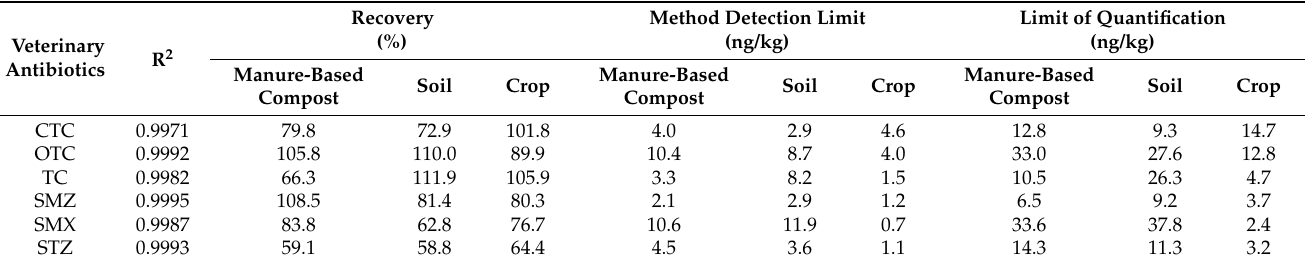
Table 1. Recovery, method detection limit, and limit of quantification of 6 veterinary antibiotics in manure-based compost, soil, and crop